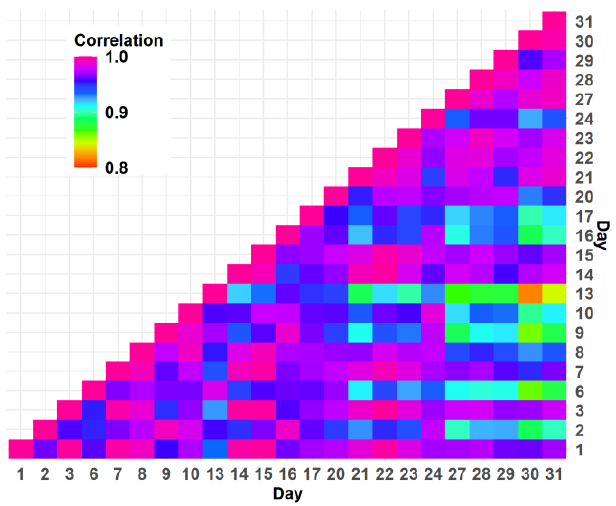
Figure 3. Correlation coefficient of daily cooling energy use in July (1, 1 July; … ; 31, 31 July).